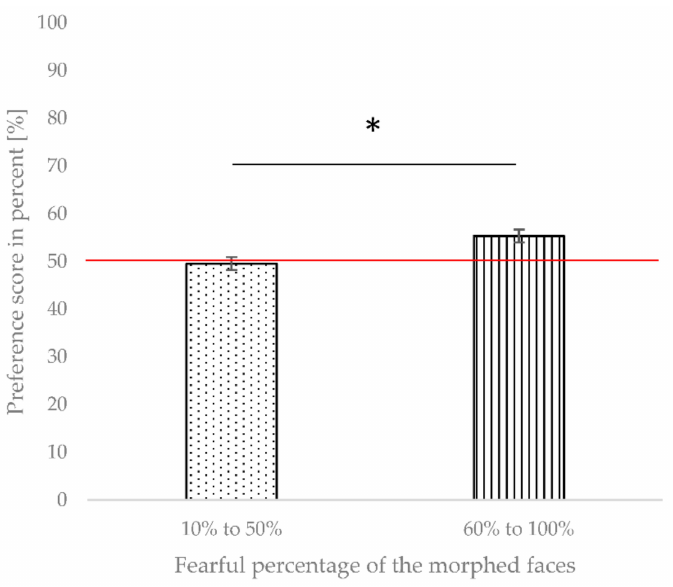
Figure 5. Comparison of preference scores for the first half of the morphing continuum (10% to 50% fearful facial expression) versus preference scores for the second half of the morphing continuum (60% to 100% fearful facial expression) for all infants regardless of crawling ability. Error bars indicate the standard error of the mean. * indicates a p -value < 0.05.